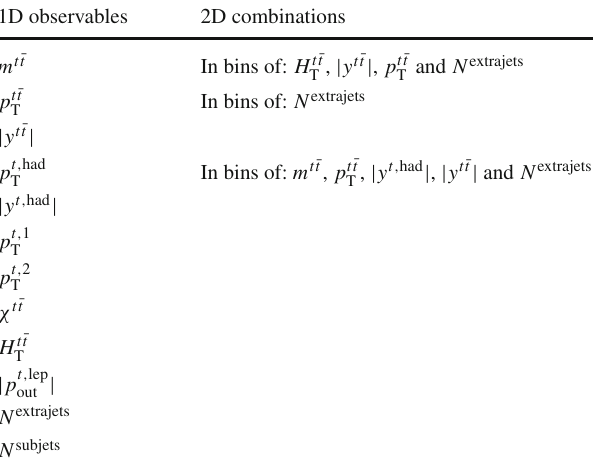
Table 7 The single- and double-differential spectra, measured in the boosted topology at particle level 1D observables 2D combinations